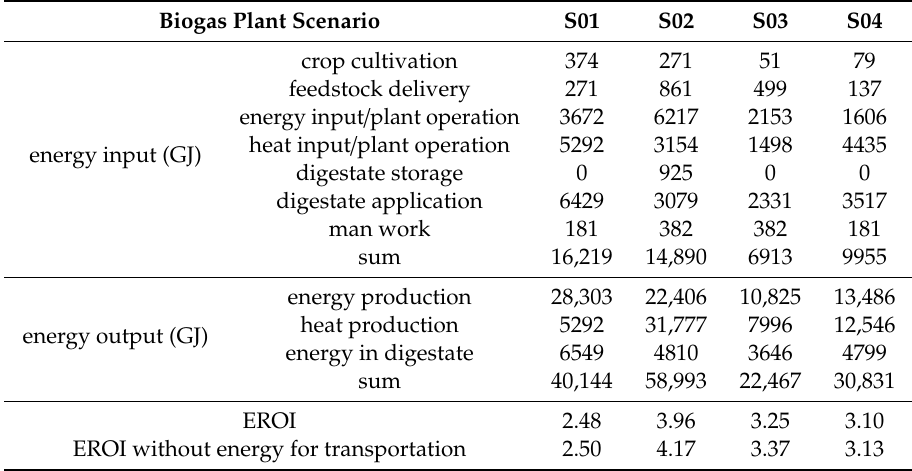
Table 5. The values of energy return on investment in a 1-year